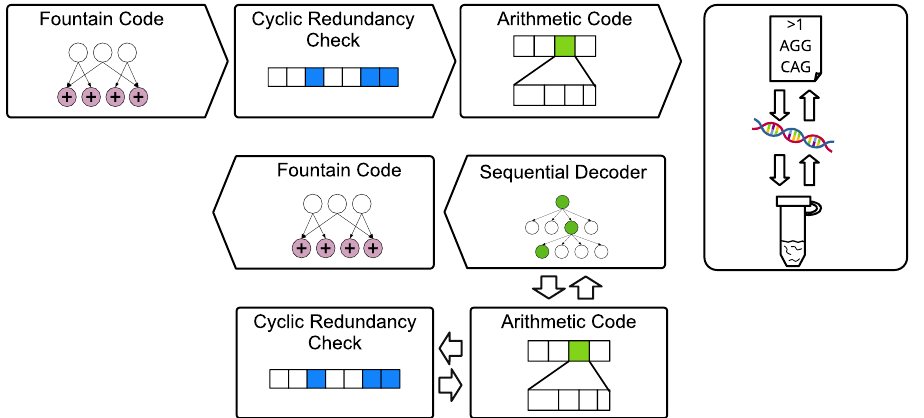
The channel output packets are decoded in parallel by the inner, sequential decoder.The sequentialdecoderstores the states of thearithmeticcode as nodes. In periodic intervals, a CRC check of the data that was decoded since the last CRC checksum is performed. The fountain code then uses the packets with the highest fi nal Fano metric to recover the original input data.